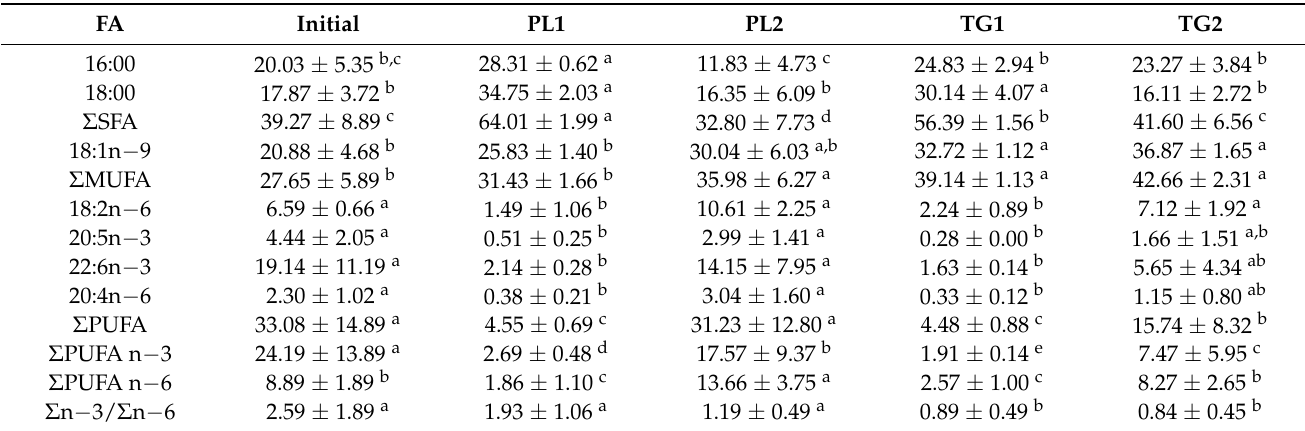
Table 8. Fatty acid percentages of the polar fractions of the muscles of dusky grouper juveniles fed the experimental